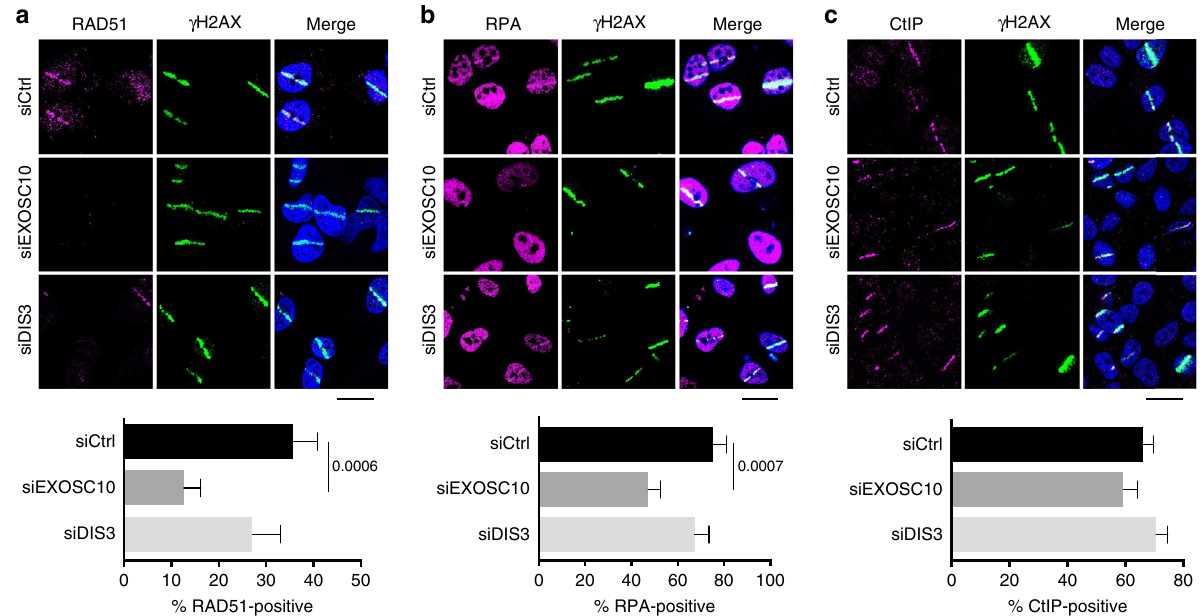
Fig. 2 Depletion of EXOSC10 impairs RPA and RAD51 recruitment to DSBs. a The panel shows RAD51 immuno fl uorescent staining of HeLa cells depleted of either EXOSC10 or DIS3 for 48 h. The cells were fi xed 30 min after UV laser micro-irradiation. The bar plot in the lower part of the fi gure shows the percentage of γ H2AX-positive stripes that were co-stained by RAD51 ( n > 35 cells analysed in each condition, from two independent experiments). b RPA immuno fl uorescent staining was performed on cells depleted of either EXOSC10 or DIS3 and fi xed 15 min after UV micro-irradiation. The bar plot shows the percentage of γ H2AX-positive stripes that were co-stained by RPA ( n > 60 cells analysed for each siRNA treatment, from at least two independent experiments). c CtIP immuno fl uorescent staining was performed on cells depleted of either EXOSC10 or DIS3 and fi xed 10 min after UV micro-irradiation. The bar plot shows the percentage of γ H2AX-positive stripes that were co-stained by CtIP ( n > 100 cells analysed for each siRNA treatment, from two independent experiments). In all panels, the error bars represent s.e.m. Statistical testing was done using a Mann – Whitney ’ s test and signi fi cant p -values are shown in the fi gure. The scale bars represent 20 μ m. Source data for Fig. 2a – c are provided as a Source Data fi